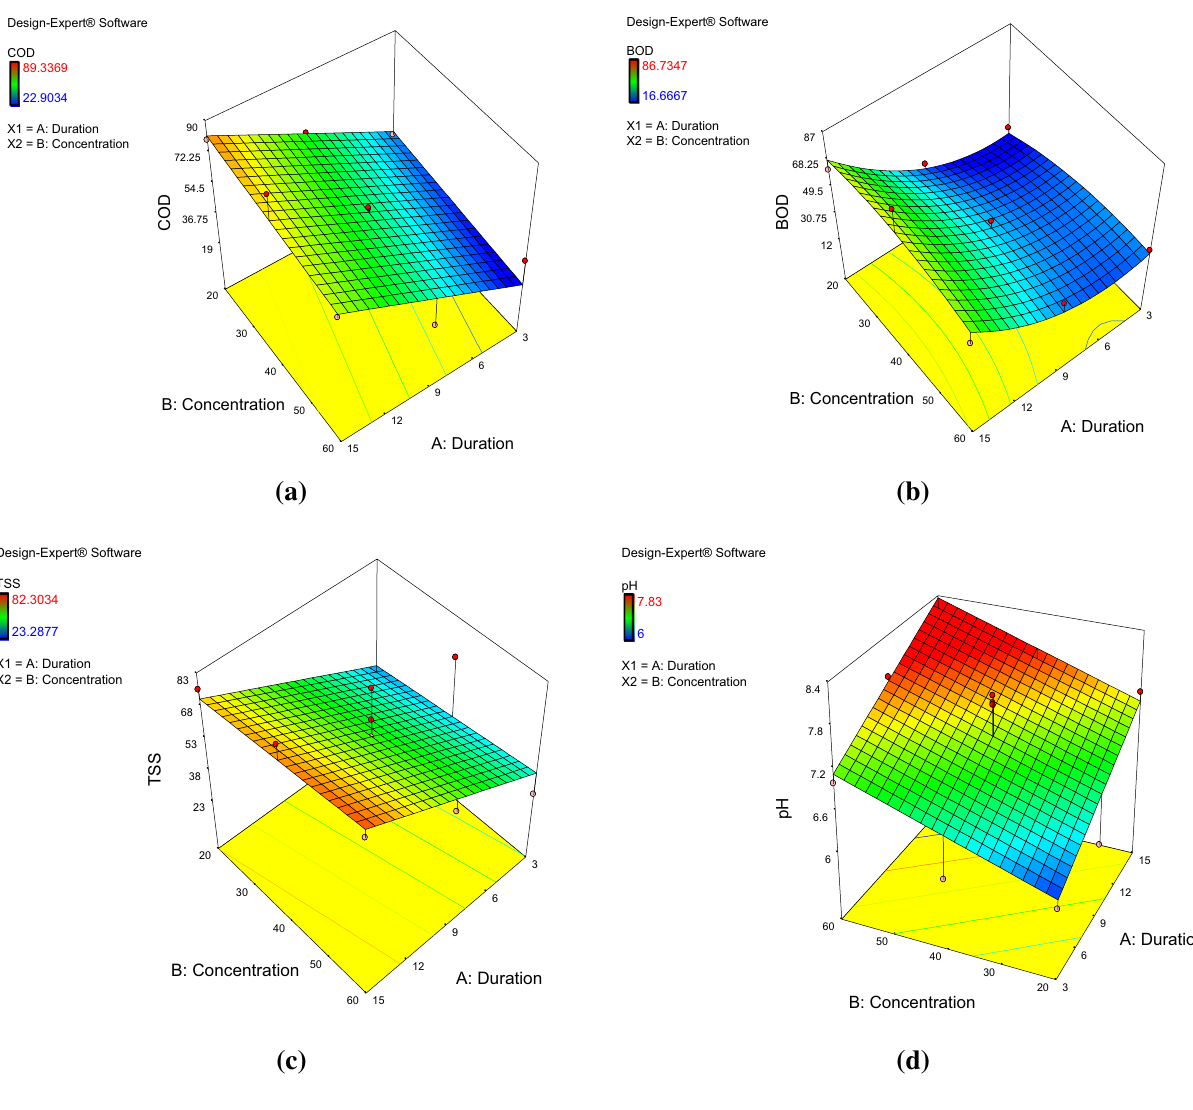
Fig. 2 Plot of 3D surface a COD, b BOD, c TSS, d